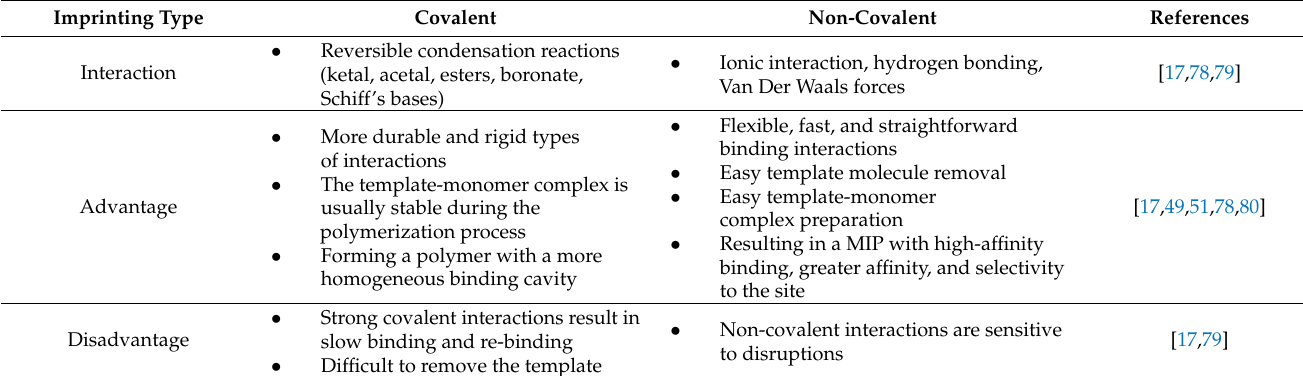
Table 1. Comparison Between Covalent and Non-Covalent Imprinting